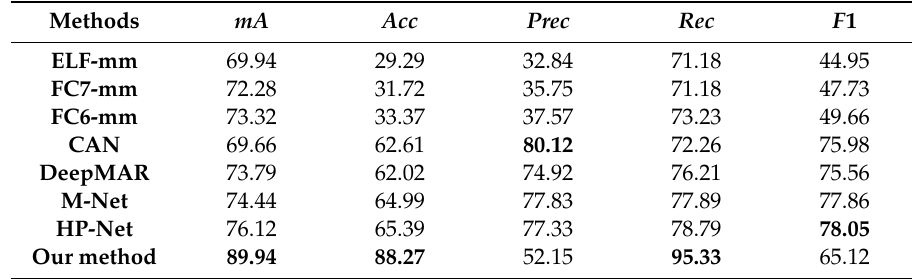
Table 4. Attribute recognition results (%) comparison on RAP dataset. The bold number is the max value on each row except the last